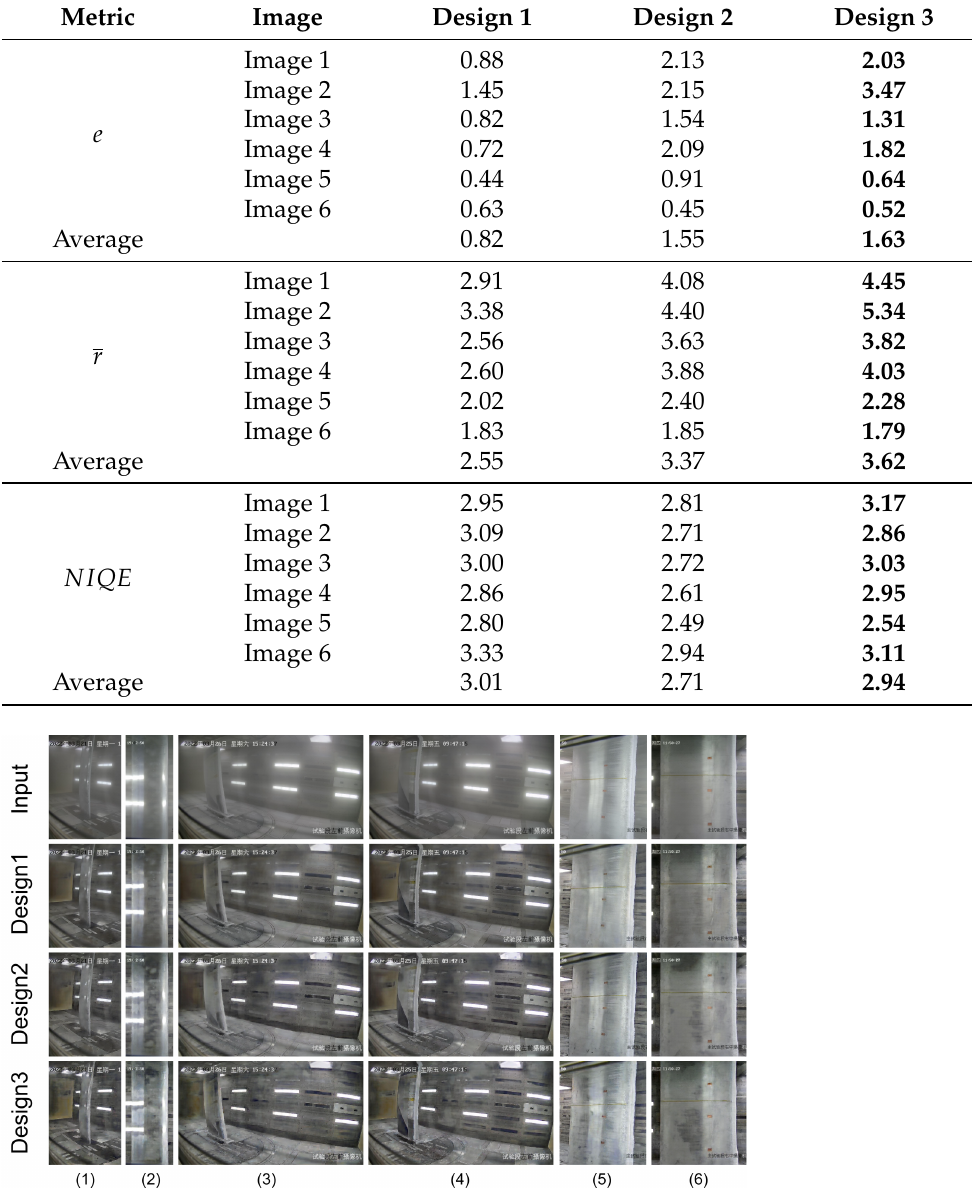
Figure 8. Comparison chart of ablation experiment effect. Design 1 means that only sub-pixel convolution is added, Design 2 means that only instance normalization is added, and Design 3 is our proposed model, which adds sub-pixel convolution and instance normalization. (( 1 – 6 ) in the picture represent Image 1 to Image